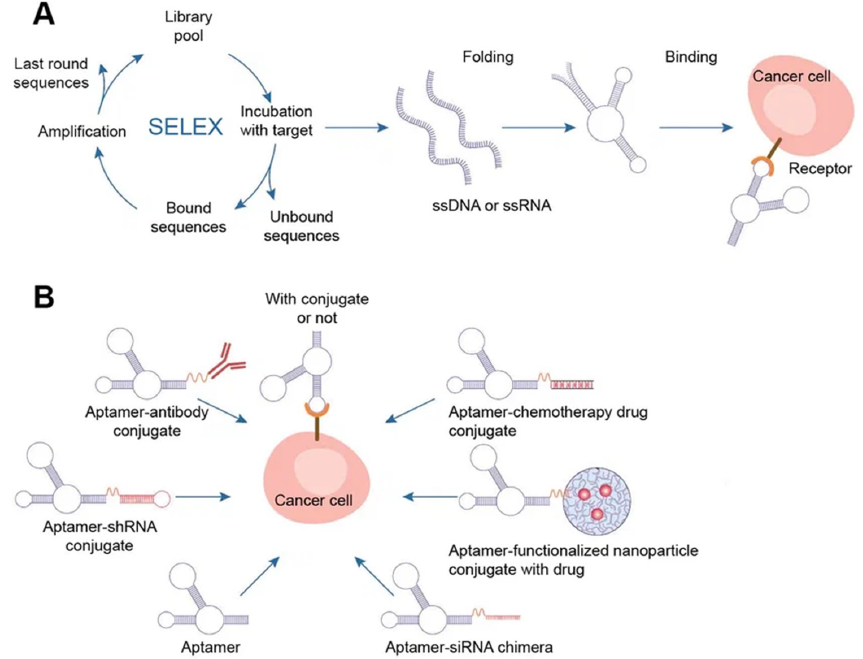
Figure 5. Aptamers. ( A ) Schematics of SELEX, aptamer folding, and binding to a target protein. A target-aptamer complex is created when the aptamer folds into a certain three-dimensional struc- ture and interacts with a target molecule (such as a protein). ( B ) Aptamers for drug delivery in